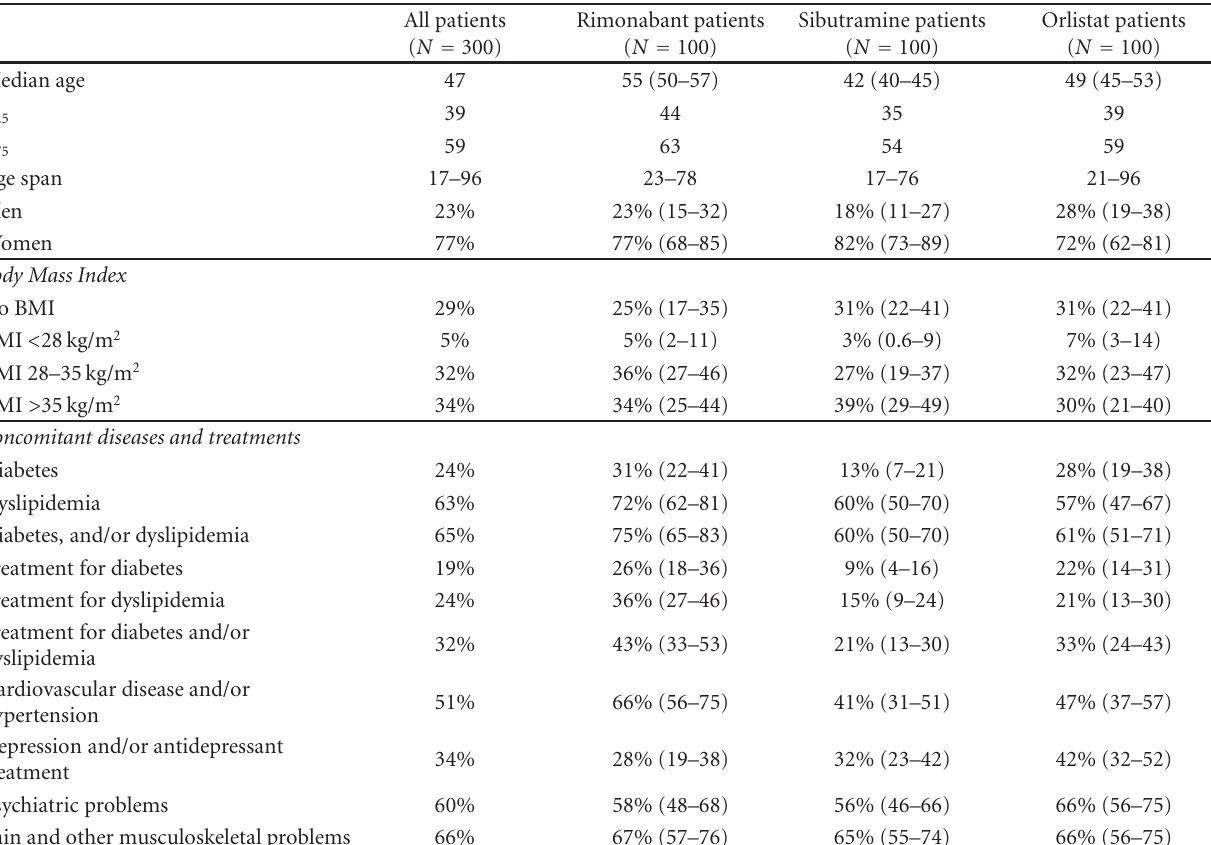
Table 2: Patient characteristics (Values within parentheses are 95% Confidence Intervals (CI). CIs around medians calculated by binomial method, and around relative frequencies by exact binomial method.).